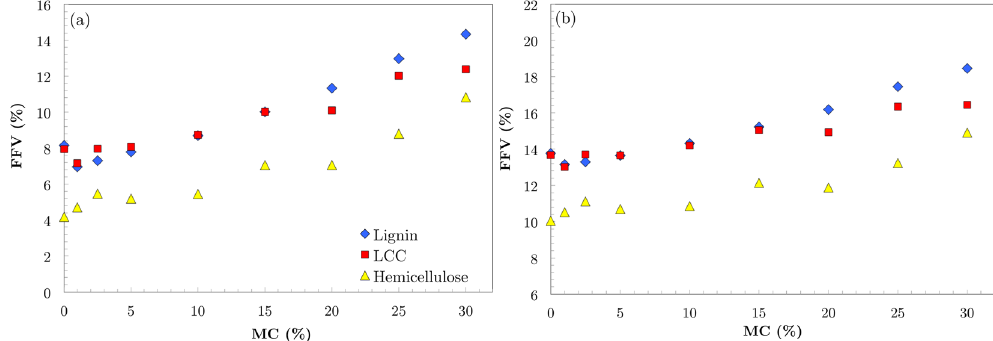
Figure 6. Variation of fractional free volume (FFV) of hemicellulose, lignin and LCC calculated by ( a ) VABC ( b ) Connolly methods. Lignin and LCC have more free space for water molecules to fit in. As the water molecules are introduced to the system, they fit into the free volume between polymer chains and reduce FFV at low MC. Hemicellulose has denser structure. Adding water molecules to this system, expands the volume and increases the portion of free volume, even at low